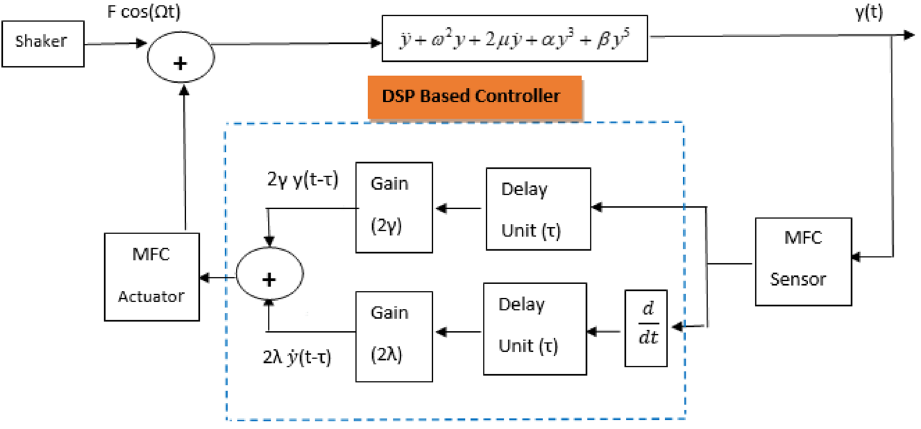
Figure 6. Explores the controlled system block